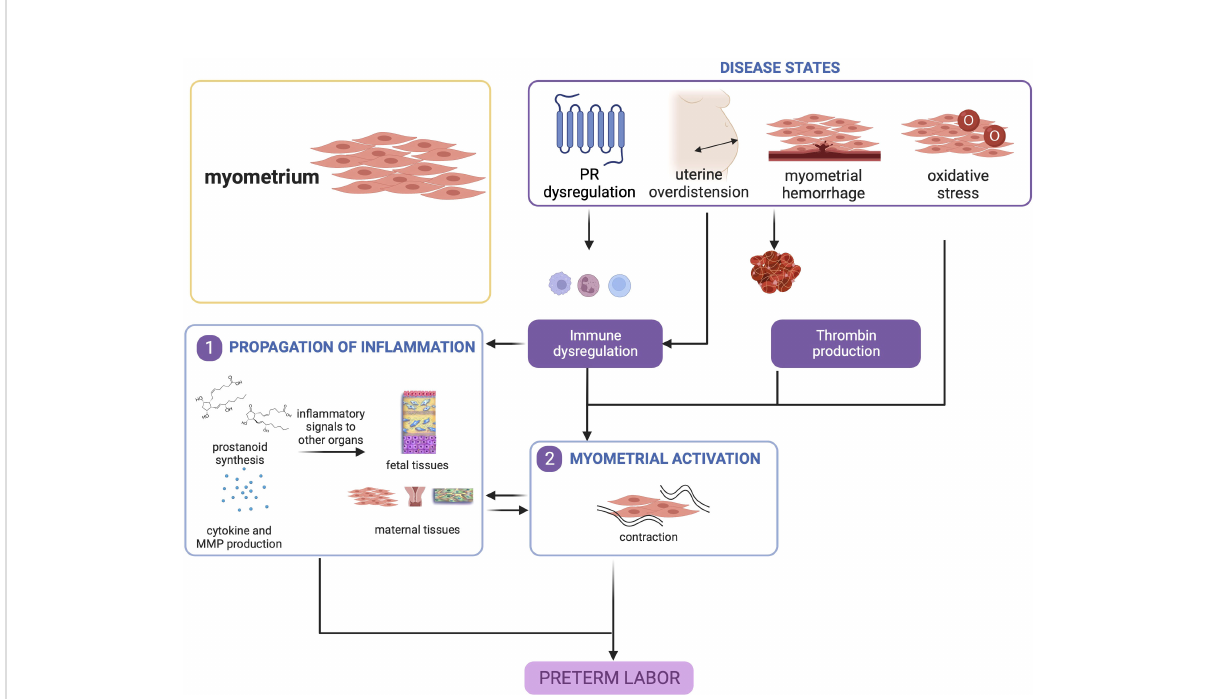
FIGURE 4 Disease states in the myometrium contribute to preterm birth. Uterine overdistension and myometrial hemorrhage, and to a lesser extent, oxidative stress, may all lead to myometrial activation that produces contractions. This fi gure was created with